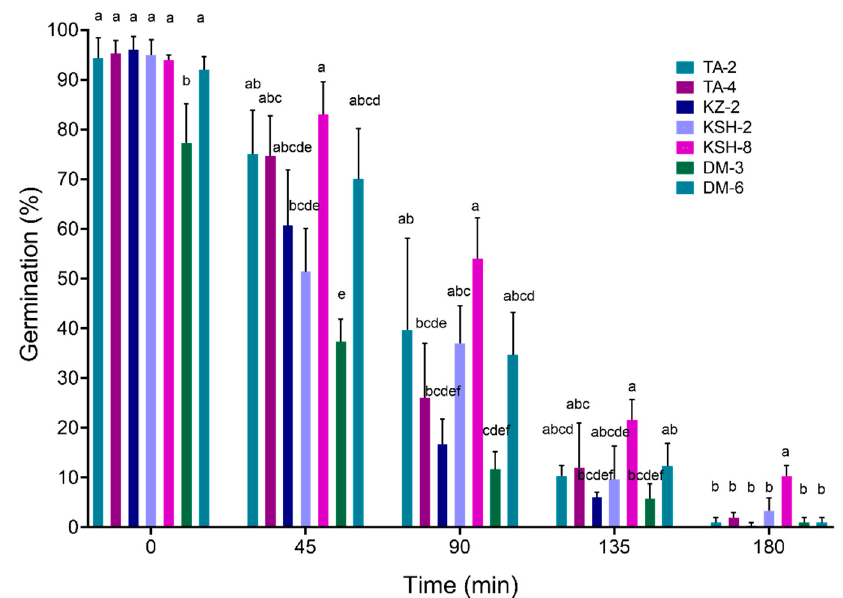
Figure 5. Conidial germination rate of selected fungal isolates after heat-treatments at 45 °C. Bars represent the average and standard deviation of 3 replicates ( n = 3). Different letters (a–f) indicate significant differences between isolates for each timepoint (one-way ANOVA with Tukey HSD, p < 0.05).